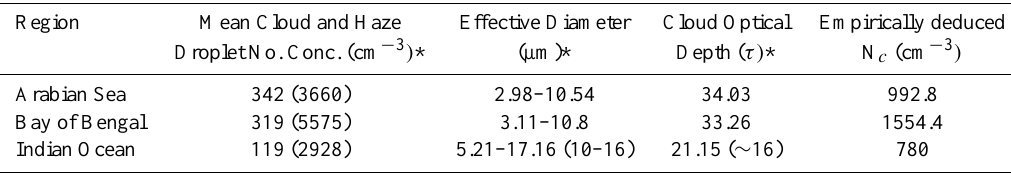
Table 2. Modelled optical properties over the three